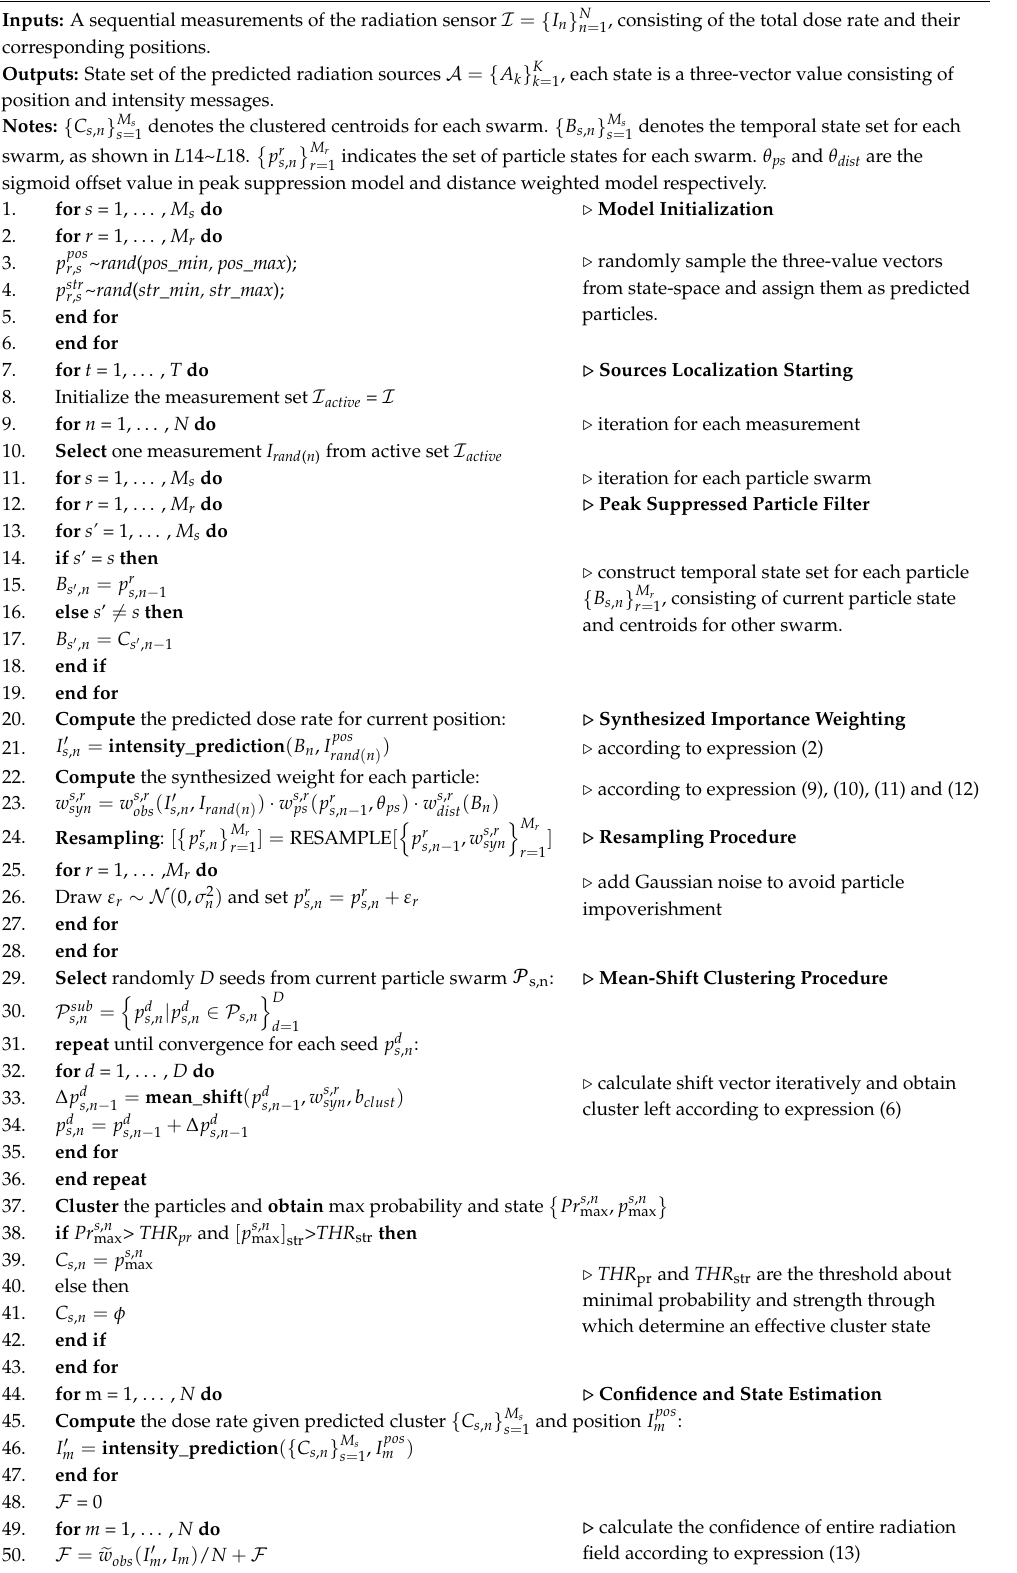
Algorithm 1 . Specific Flowchart of the Cross-mixed Multiple Radiation Sources Localization Algorithm based on Peak Suppressed Particle Filter (PSPF)